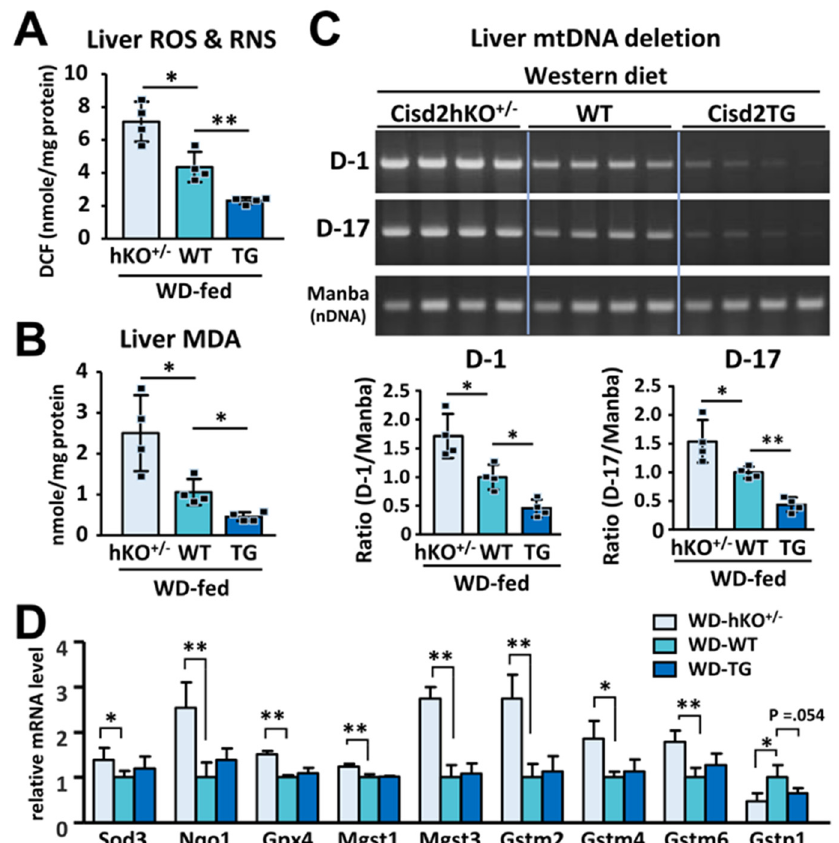
Figure 5. An inverse correlation between Cisd2 level and WD-induced oxidative stress in the liver. ( A ) Total reactive species levels (ROS/RNS) in the liver tissues of WD-fed mice ( n = 4). ( B ) Hepatic contents of malondialdehyde (MDA) ( n = 4). ( C ) Deletions of mitochondrial genome (mtDNA) in the liver tissues of WD-fed mice. Manba is a control nuclear gene ( n = 4). ( D ) Differentially ex- pressed genes involved in antioxidant defense in the liver tissues of WD-fed mice. The mean value of WT control group was set as 1 ( n = 4). Data are presented as mean ± SD. * p < 0.05; ** p < 0.005.